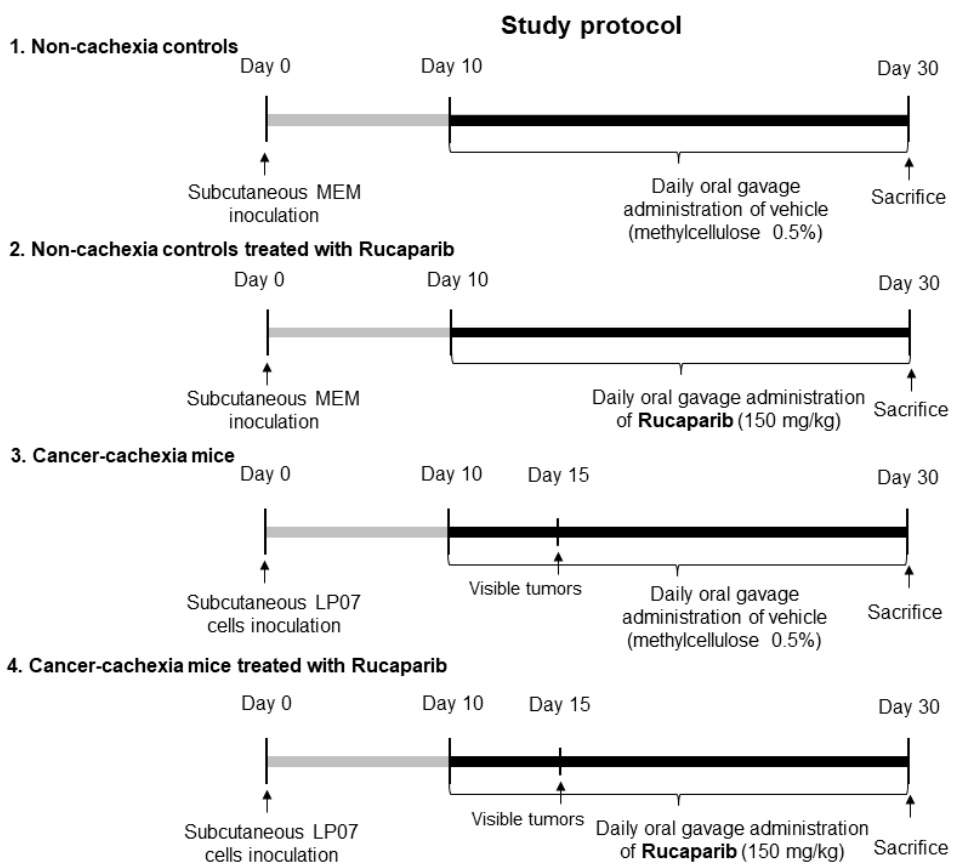
Figure 1. Schematic time-line representation of the study protocol in the four studied groups.